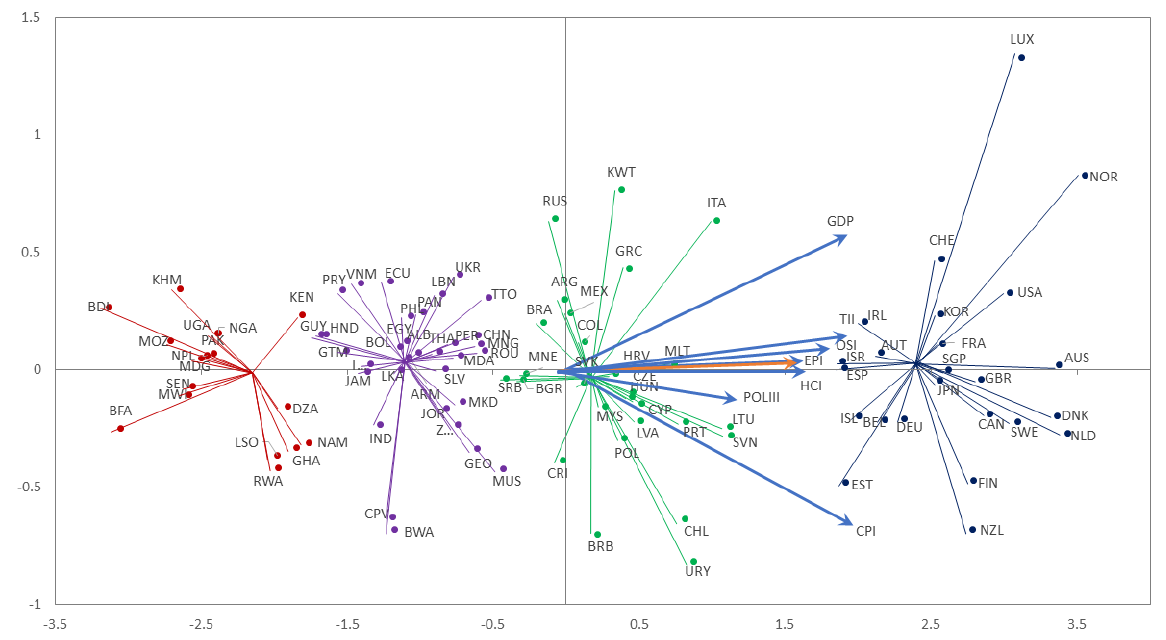
Figure 4. X-Statis Compromise subspace: position of Figure 4. X - Statis Compromise subspace: position of indicators.